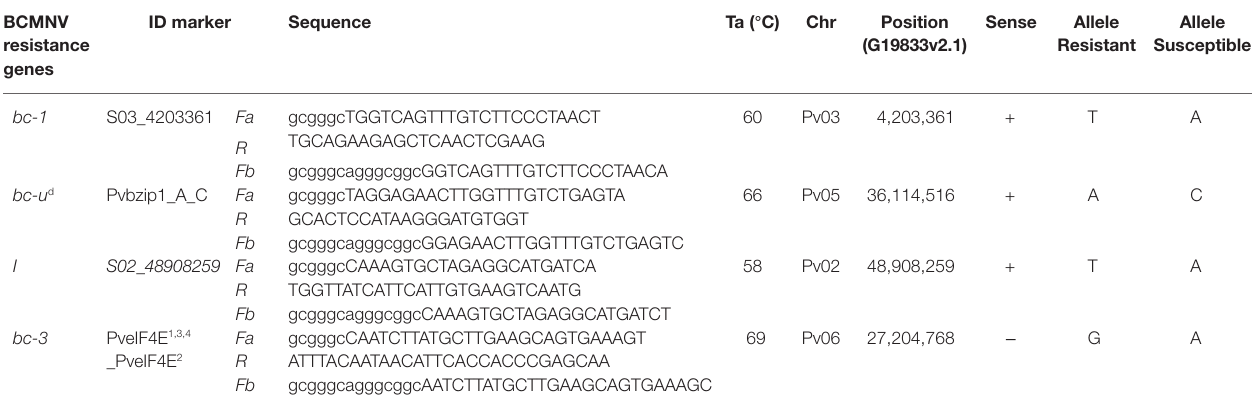
TABLE 1 | Primers were used to generate markers for bc-1 , bc-u d , I , and bc-3 genes conditioning resistance to Bean common mosaic necrosis virus (BCMNV) and Bean common mosaic virus (BCMV). BCMNV resistance